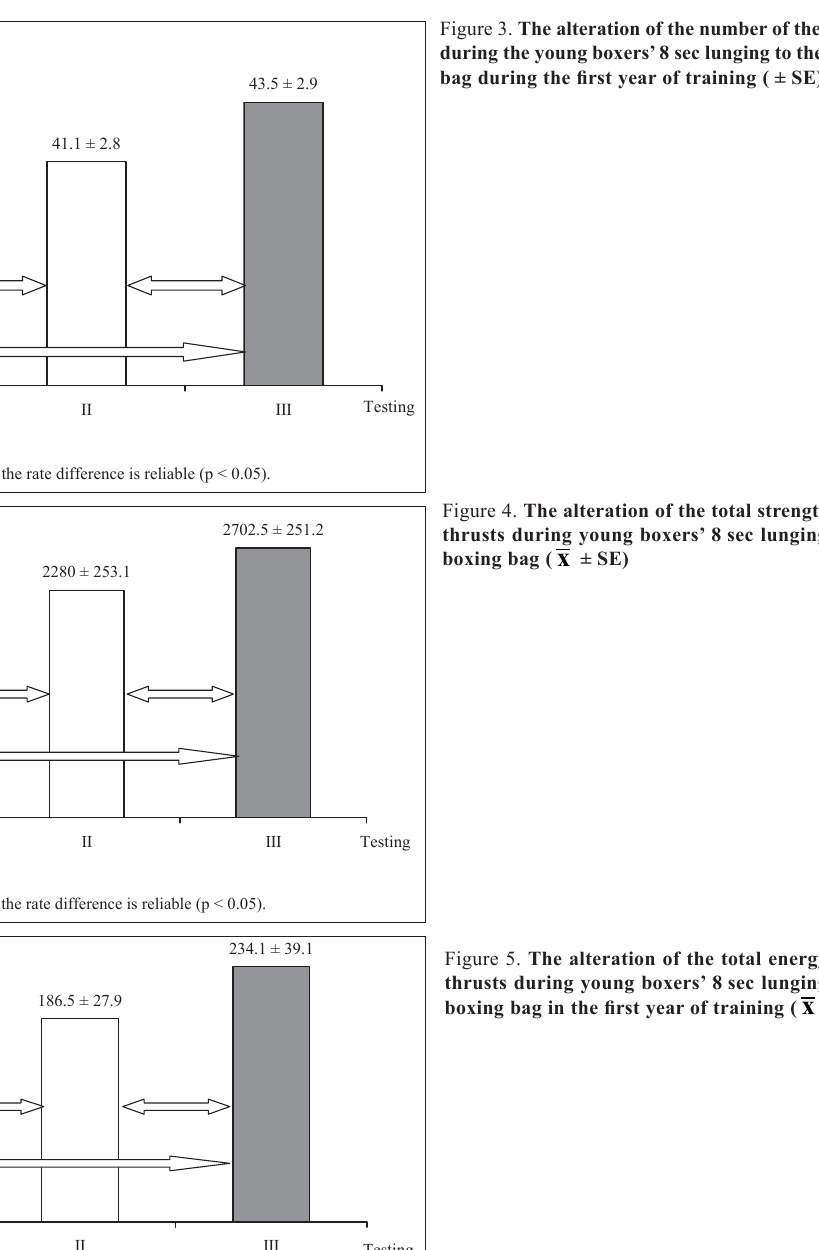
Figure 5. The alteration of the total energy of the thrusts during young boxers’ 8 sec lunging to the boxing bag in the fi rst year of training ( x ±